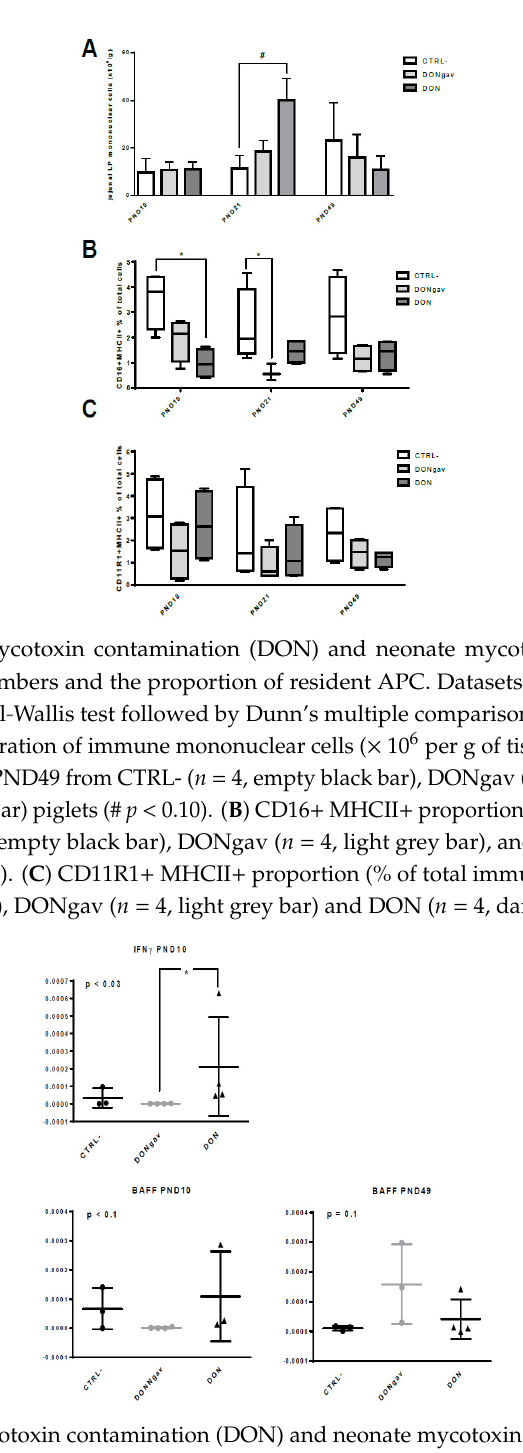
Figure 8. Sow diet mycotoxin contamination (DON) and neonate mycotoxin gavage (DONgav) effect on gene expression of unstimulated jej ‐ LP explants. Datasets were analyzed with the non ‐ parametric Kruskal-Wallis test ( p -value on left corner of each graph) followed by Dunn’s multiple comparison tests when appropriate (CTRL- vs. DONgav vs. DON). qRT-PCR gene expression of unstimulated jej-LP explants of CTRL- ( n = 3, full black circle), DONgav ( n = 3–4, full grey circle) and DON ( n = 3–4, full black triangle). The relative gene expression was determined using the cycle threshold (Ct) method and normalized to the expression of the two housekeeping genes (Ct of gene of interest over mean Ct). Differences in unstimulated il ‐ LP explant gene expression level between DONgav vs. DON are displayed with * p < 0.05.